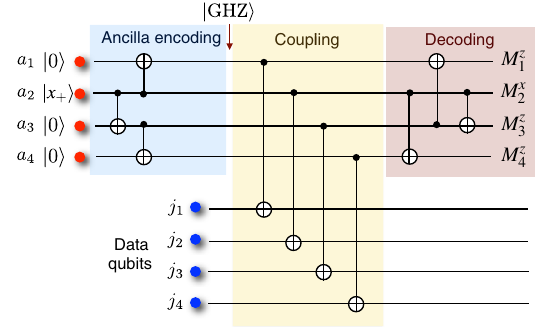
FIG. 10. CNOT -based circuit for DiVincenzo-Aliferis-type QEC: This circuit involves the preparation of an ancilla four-qubit GHZ state by CNOT gates, its transversal coupling to the data qubit layer, the ancilla state decoding, and the measurements of the